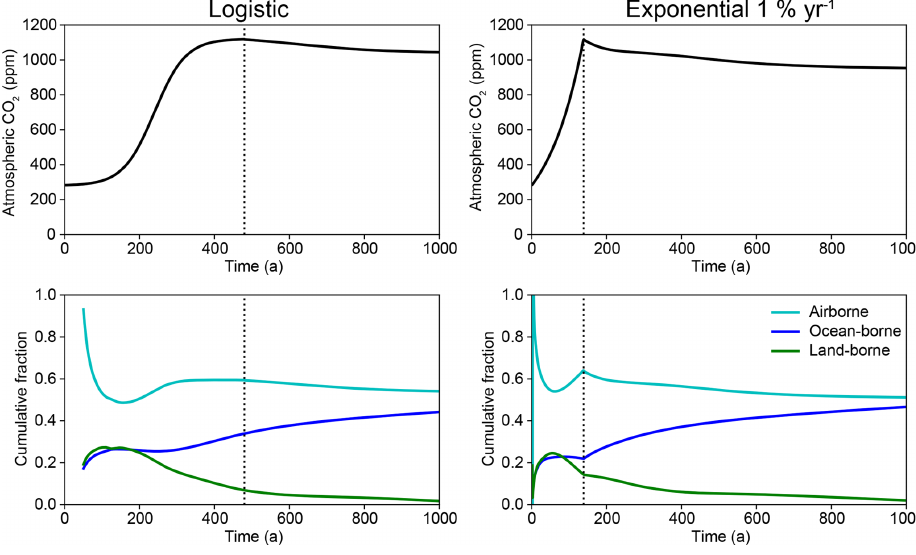
Figure 10. Evolution of atmospheric CO 2 concentration and cumulative carbon fractions for logistic and 1% experiments followed by net zero CO 2 emissions. Vertical dotted lines mark the transition from prescribed atmospheric CO 2 concentration to zero emissions with free- evolving atmospheric CO 2 concentrations. Recall that instantaneous carbon fractions are not defined when emissions are zero (i.e. division by